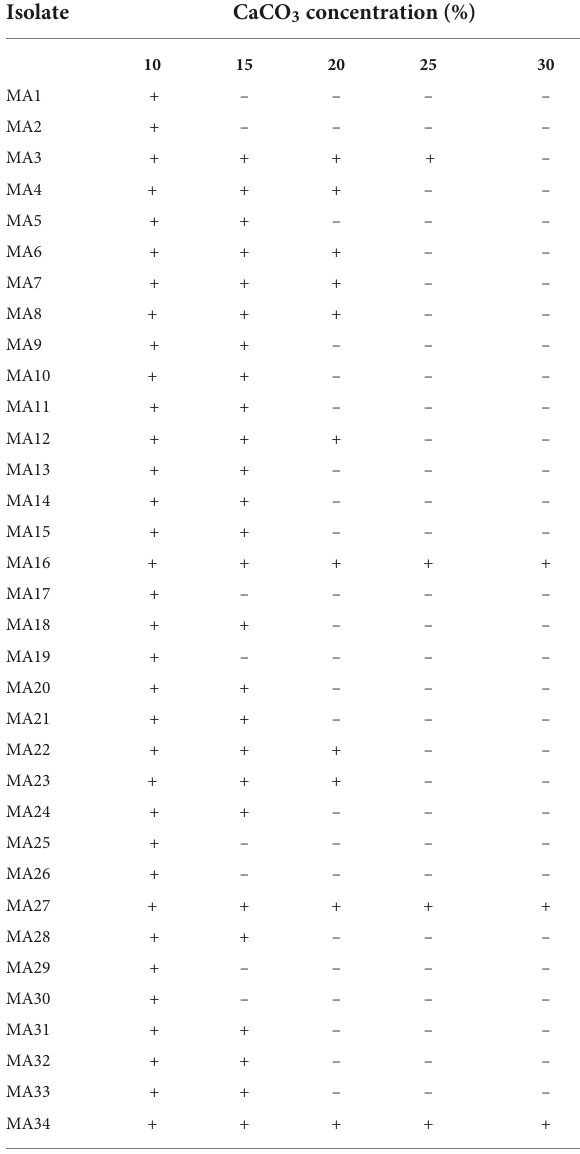
TABLE 1 Isolation and screening of calcium carbonate precipitating bacteria (CCPB).